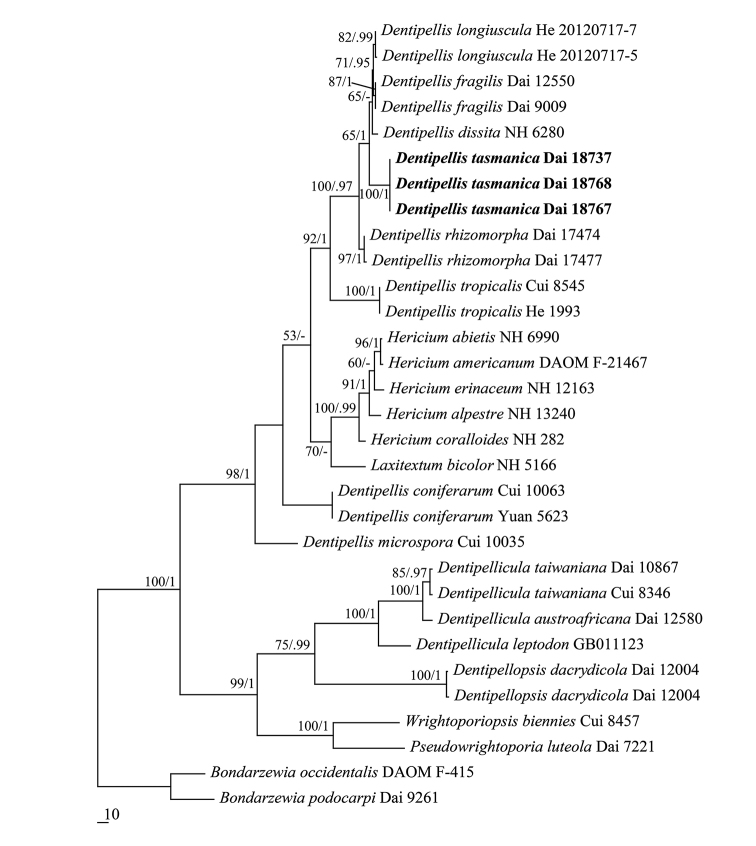
Strict consensus tree illustrating the phylogenetic position of Dentipellistasmanica, generated by the maximum parsimony method based on ITS+28S sequence data. Branches are labelled with parsimony bootstrap values ≥50% and Bayesian posterior probabilities ≥0.95. Bondarzewiapodocarpi and B.occidentalis are used to root the tree. Branch lengths reflect expected changes per site as indicated by the scale.